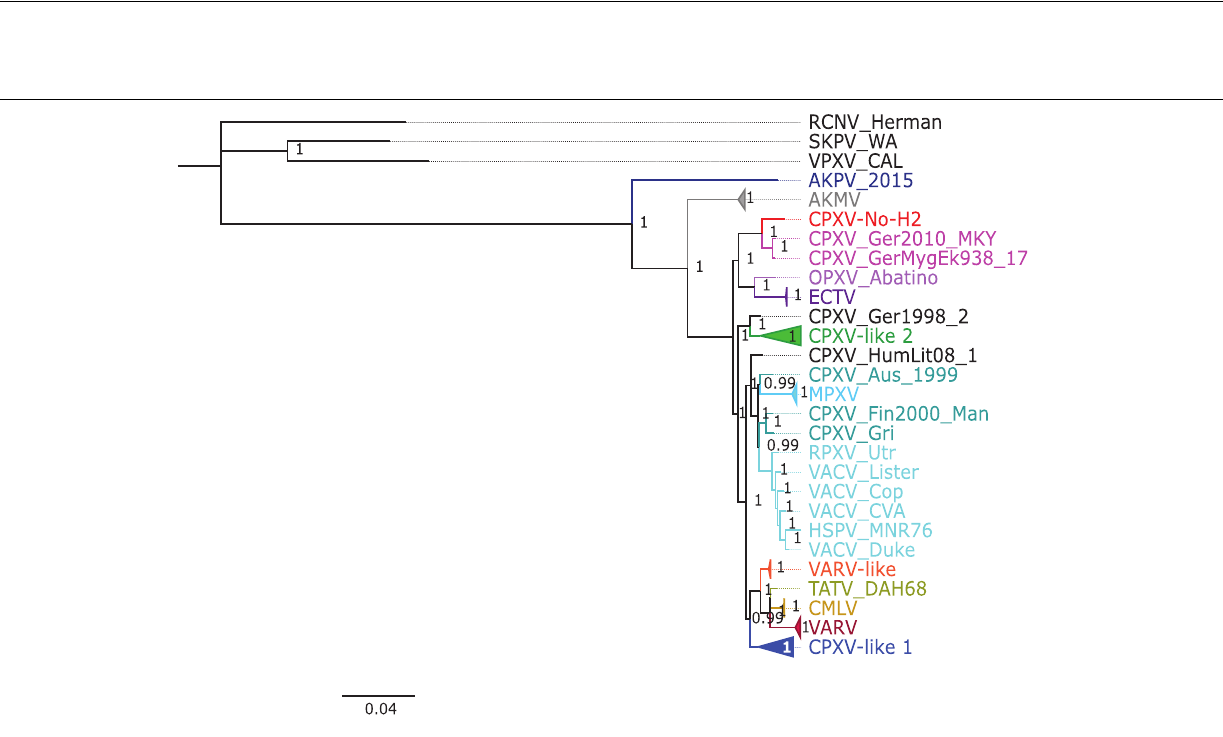
FIGURE 3 | Bayesian inference phylogenetic tree based on 76 orthopoxvirus core genomes. Posterior probabilities are shown on the right side of each node, and only posterior probabilities above 0.6 are shown. The cowpox virus (CPXV) strains were grouped into different clades: CPXV-like 1, CPXV-like 2, and VARV-like (Franke et al., 2017). The scale bar represents the expected substitutions per